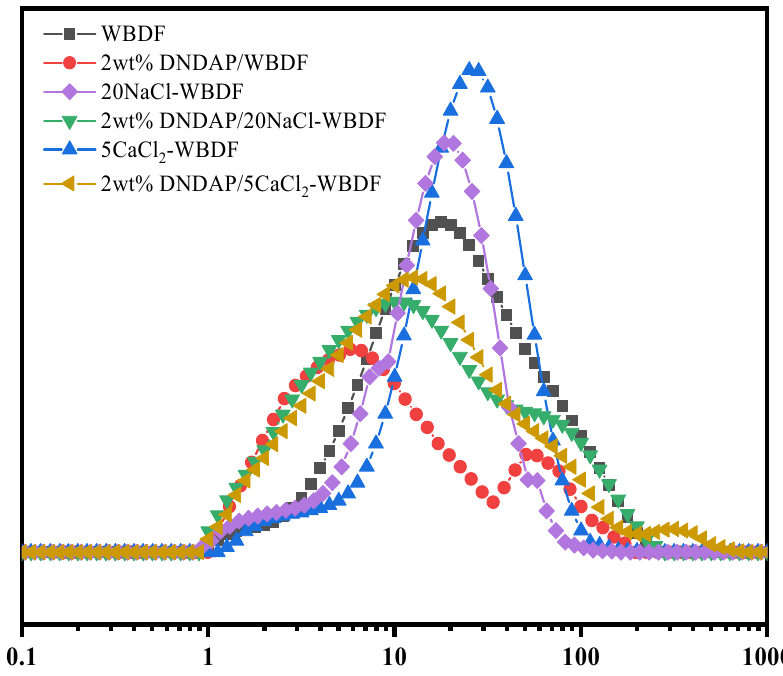
Figure 9. Size distribution of the WBDF under different conditions after aging at 200 °C for 16 h.